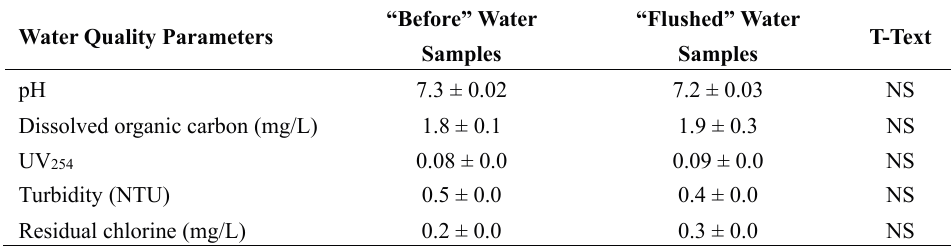
NS indicates no significant difference between “before” and “flushed” water samples (n =